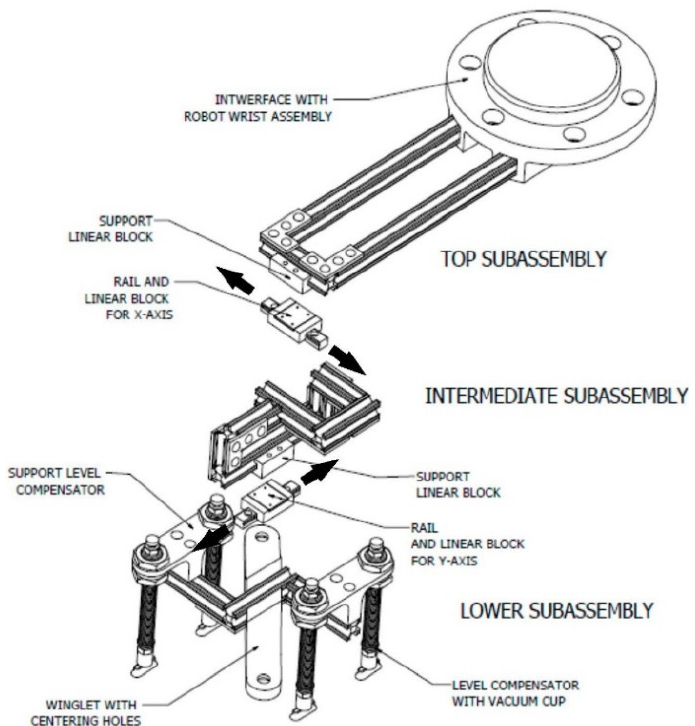
Figure 2. Partially exploded view of the end-effector depicting its main